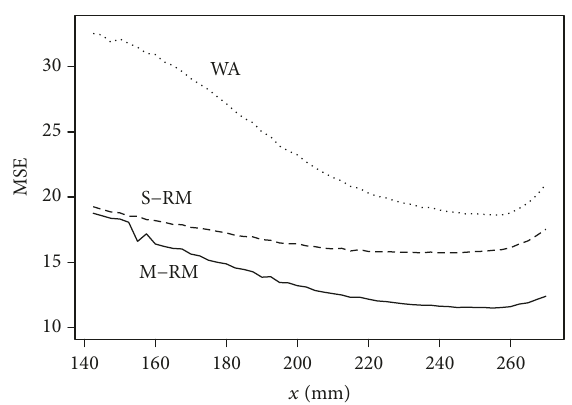
Figure 6: The MSE value for three predictive methods: WA (dotted line),S-RM(brokenline)andM-RM(solidline).Thehorizontalaxis indicates the distance 𝑥 (mm) from the cutoff point. For M-RM, the MSE value indicates the value of MSE (105.0, 𝑥) with 𝑥 1 = 105.0 and 𝑥 = 𝑥 in (10). 2